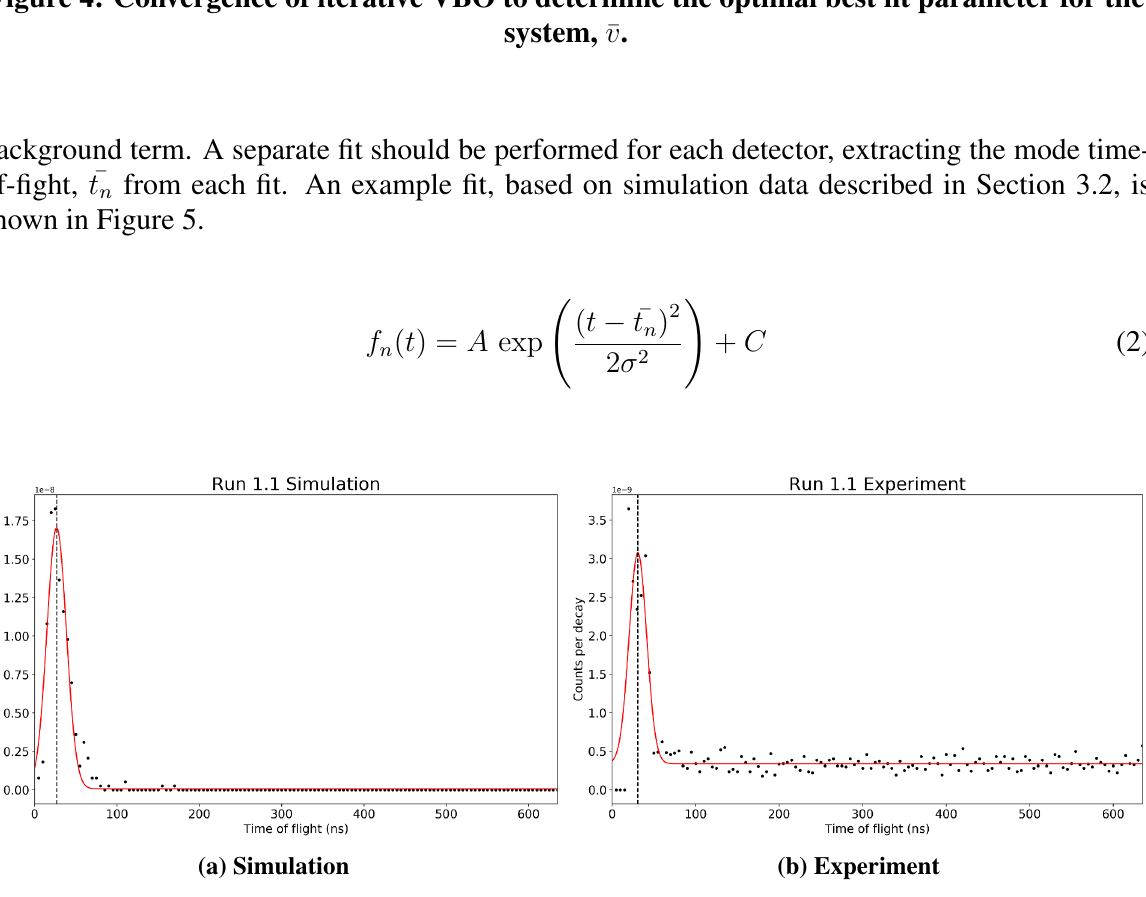
Figure 5: Gaussian fit example to time-of-flight histogram, for simulation and experimental data shown in Section